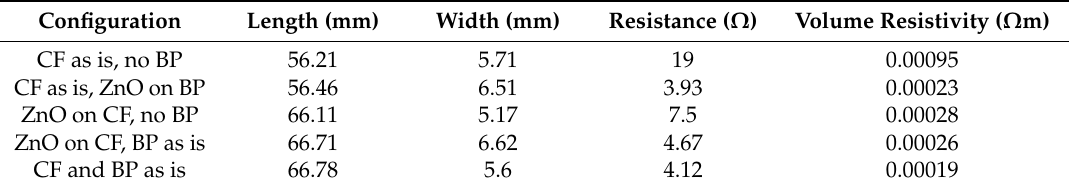
Table 4. The trend of surface resistivity for various configurations of two-layer composite samples. Configuration Length